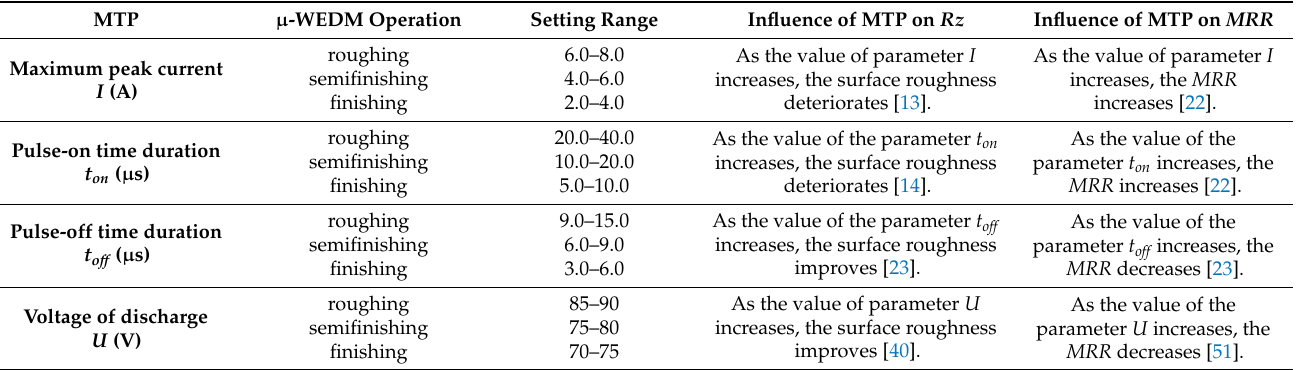
Table 1. The range of MTP settings for µ -WEDM and their influence on the output parameters MRR and